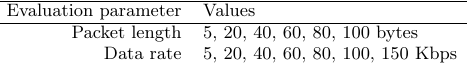
Table 4: Set of network parameters. Repeated for CM 1 and CM